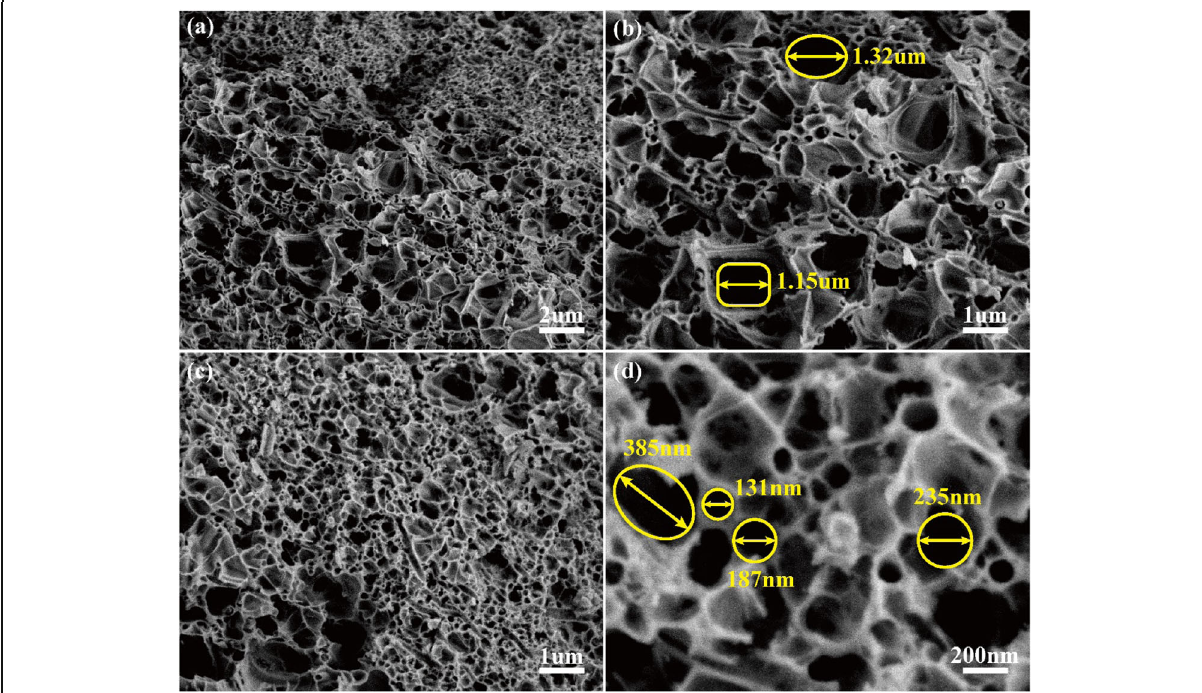
Fig. 2 The SEM images of HPSCs at different magnification: a × 5.0 k, b × 10.0 k, c × 10.0 k, and d × 50.0